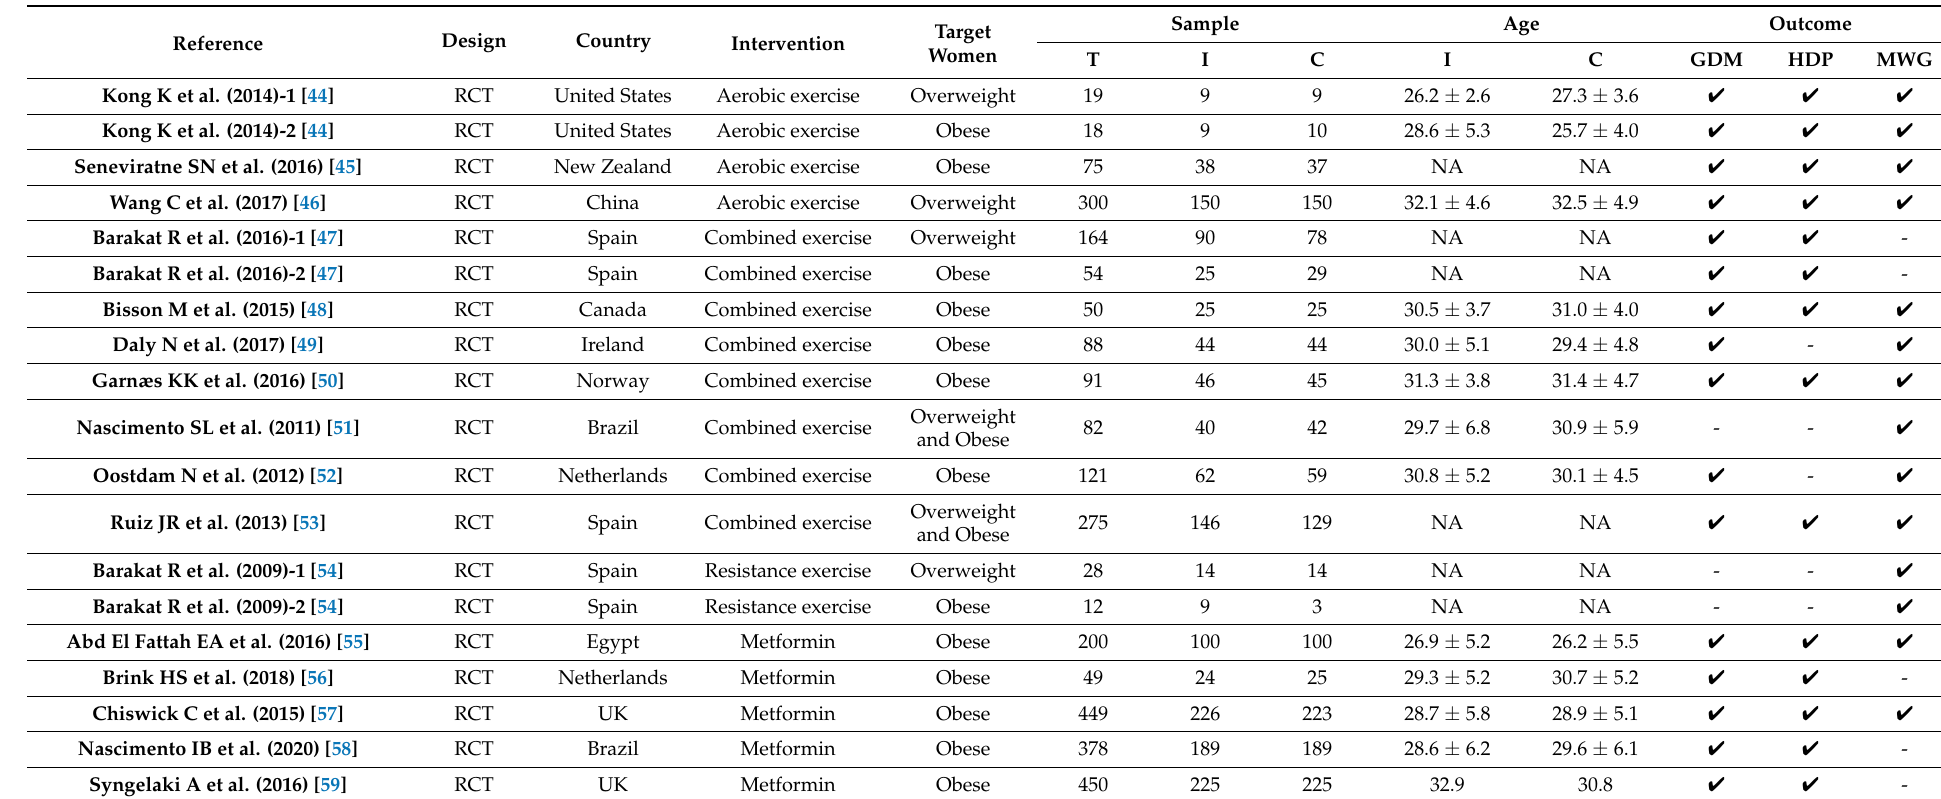
Table 1. Characteristics of included